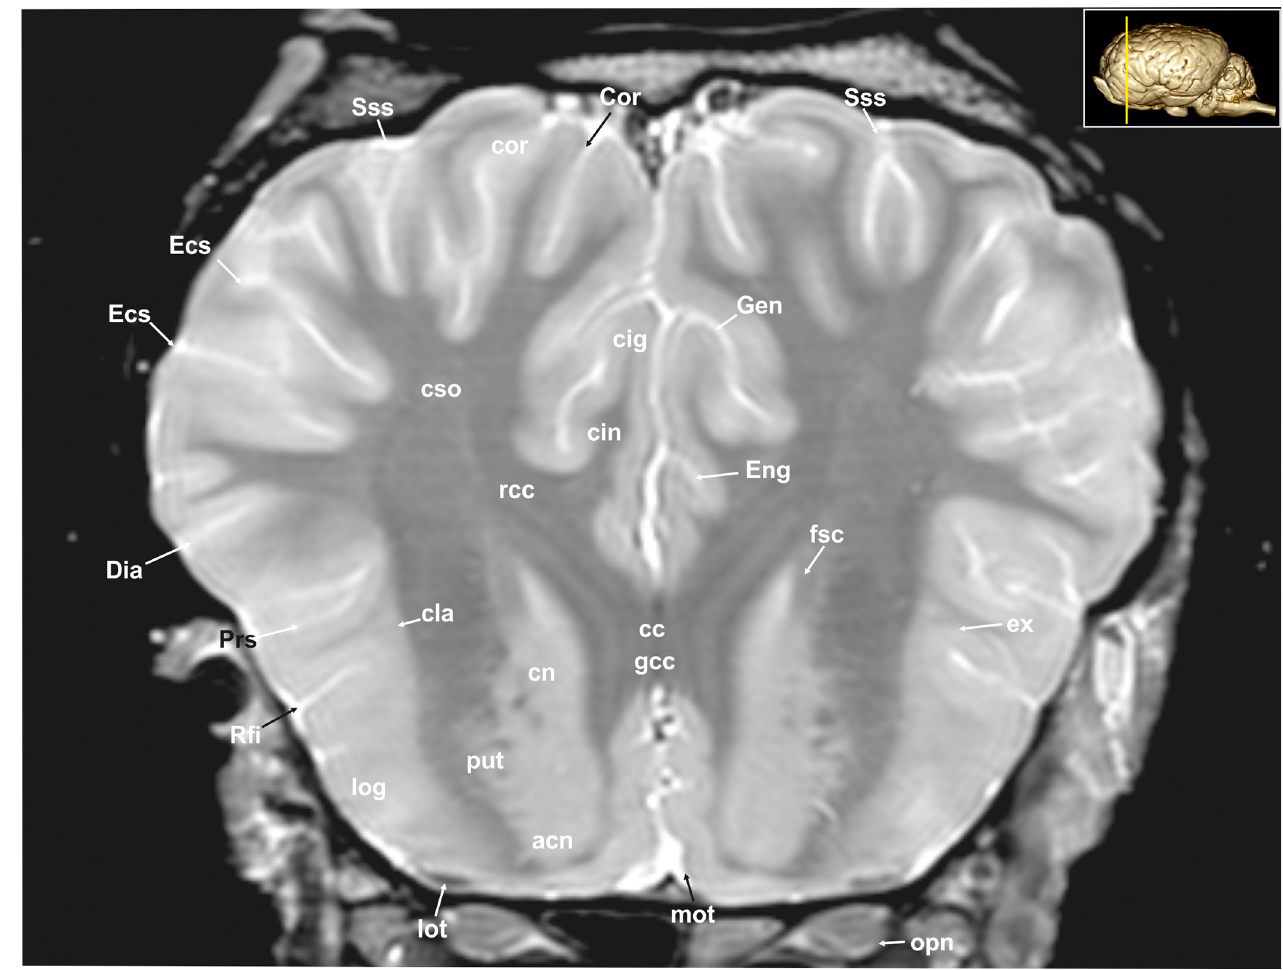
Fig 3. Transverse magnetic resonance image of the equine brain at the level of the genu of the corpus callosum. acn: accumbens nucleus, cin: cingulum, cig: cingulate gyrus, cla: claustrum, cn: caudate nucleus (caput), Cor: coronal sulcus, cor: coronal gyrus, cso: centrum semiovale, Dia: diagonal sulcus, Ecs: ectosylvian sulcus, Eng: endogenual sulcus, ex: extreme capsule, fsc: subcallosal fasciculus, gcc: genu of the corpus callosum, Gen: genual sulcus, log: lateral olfactory gyrus, lot: lateral olfactory tract, mot: medial olfactory tract, opn: optic nerve, Prs: presylvian sulcus, put: putamen, rcc: radiation of corpus callosum, Rfi: rhinal fissure, Sss: suprasylvian sulcus.